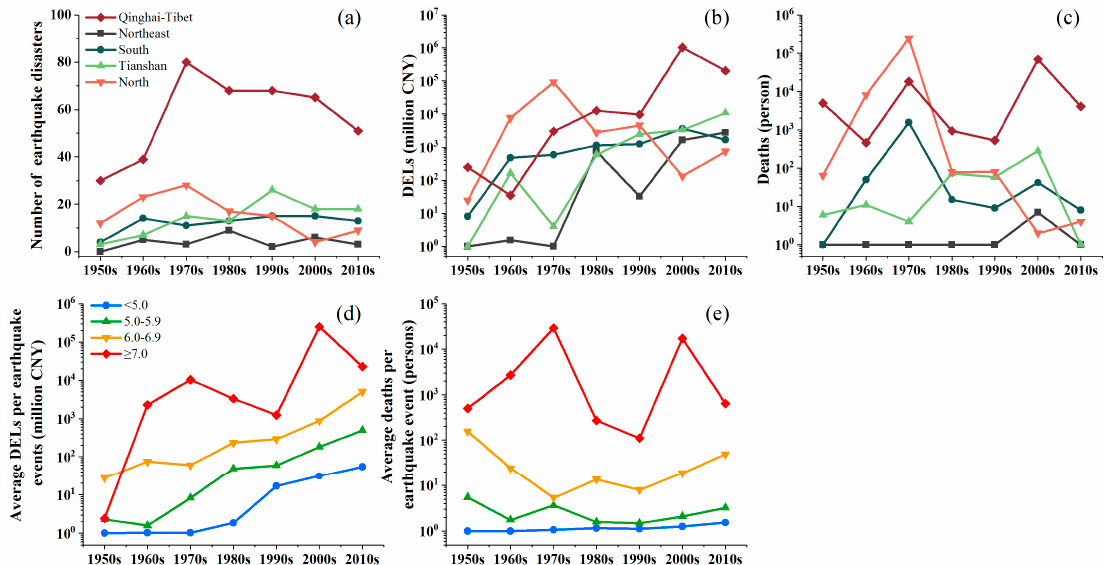
Figure 4. Decadal variability in the number of earthquake disaster, deaths, and DELs by seismic zone ( a–c ) and decadal average DELs and deaths per earthquake event by earthquake magnitude ( d , e ). The y axes in ( b – e ) are on the logarithmic scale, and a value of 1 was added to the DELs and deaths values to avoid a value of zero. Legends for b and c are the same as that for a , and the legend for e is the same as that for d .